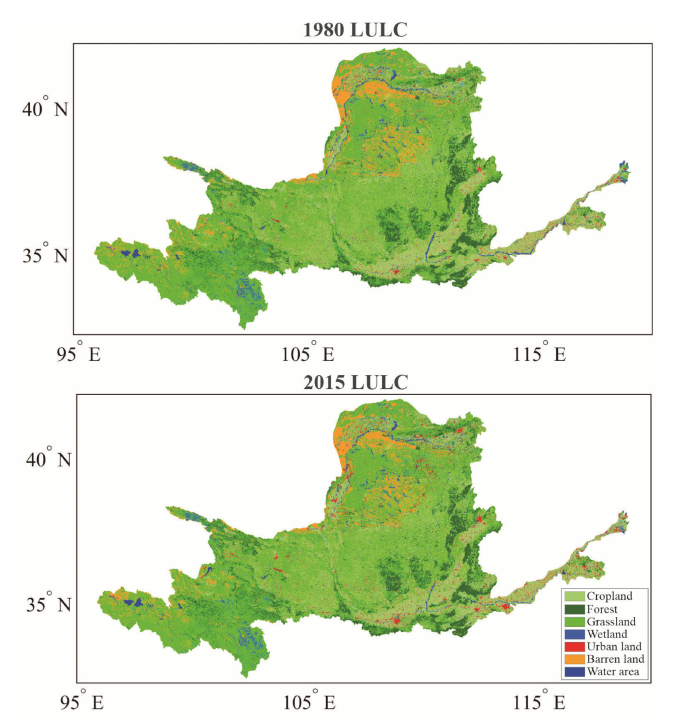
Figure 2. Areas of LULC in YRB, SA, UA, MA, and DA from 1980 to 2015. Compared with 1980, the area of urban land, water bodies, and urban lands in the YRB increased by 45.10%, 3.44%, and 2.58% in 2015, while wetland, bare land, grassland, and farmland decreased by 7.18%, 2.27%, 1.31%, and 1.29%, respectively. However, only the average annual change rate (ACR) of urban land area continued to increase (Table A3), with the ACR reach its maximum value in 2010–2015 period (0.0673 Mha/a), while other LU/LC trends showed significant reversals or fluctuations, for example, the LU/LC with the largest variation in the ACR is grassland, and its maximum and minimum ACR values occurred in 1990–1995 period (0.1540 Mha/a) and 1995–2000 period ( − 0.1896 Mha/a), respectively. Details of average annual LULC change rate in YRB from 1980 to 2015 can be found in Table